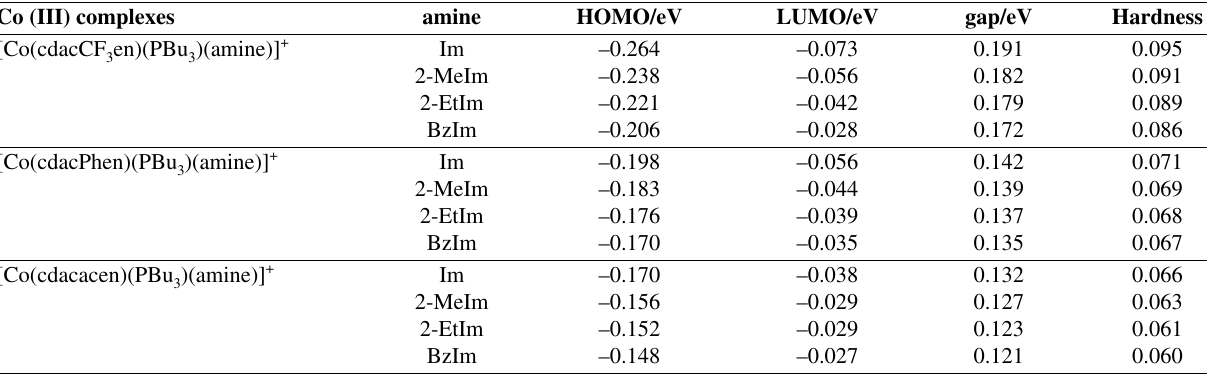
Table 7. The computed electronic properties of Co(III) complexes with B3LYP/6-311G** level. Co (III) complexes